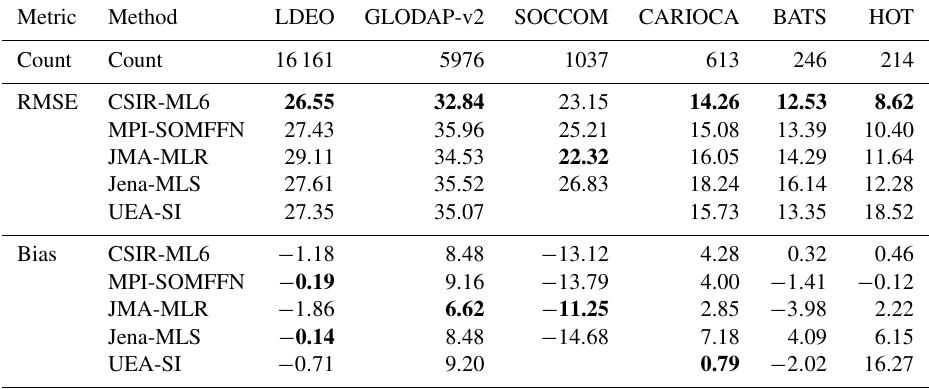
Table 5. The RMSE and bias for each gap-filling method compared to the validation datasets. For more information on the validation datasets, see Table 2. The first row of data (count) shows the number of gridded samples in the dataset during the period 1990–2015 (that are not in the SOCAT v5 gridded product). Values shown in bold are significantly different from the mean for the column ( p < 0 . 05 for the two-tailed Z test; absolute values are used for the biases). The UEA-SI method does not have error estimates for SOCCOM floats as these two time series do not